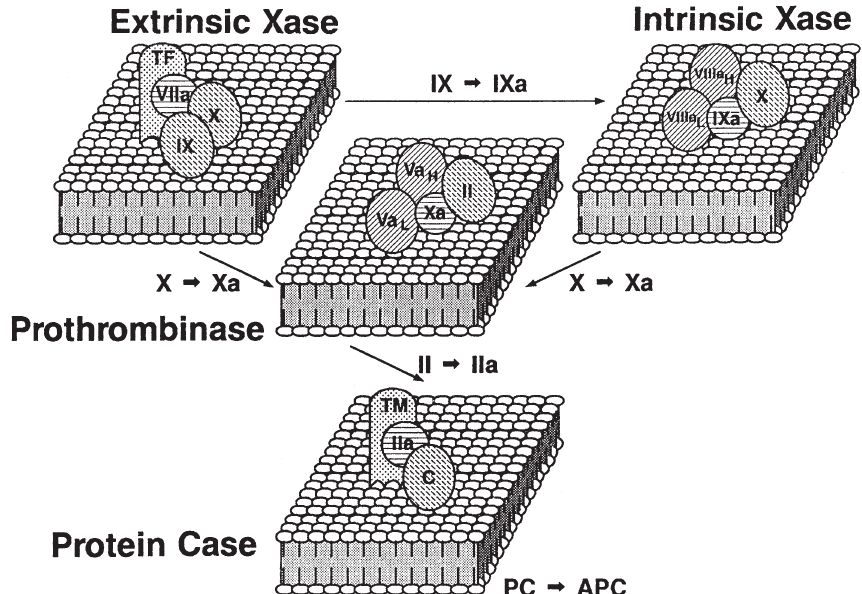
Schematic represen- tation of the vitamin K-dependent enzyme complexes responsi- ble for activation of factors X and IX (Xase), II (prothrom- binase) and protein C (protein Case). Each serine protease is as- sociated with the specific cofactor on a phospholipid surface. TF, tissue factor; TM, thrombomodulin; APC, activated